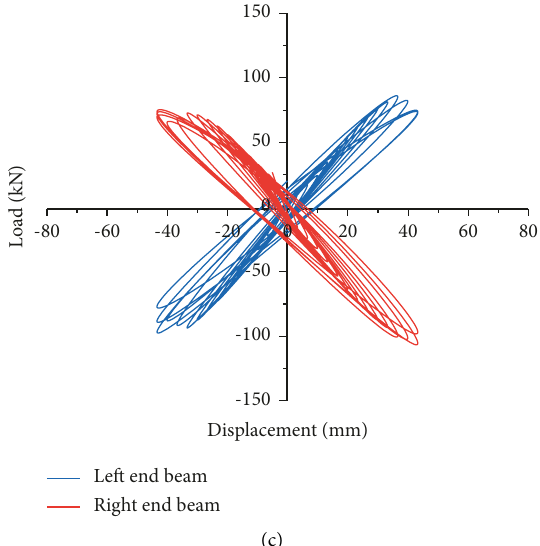
Figure 11: Load-displacement hysteretic curves of the beam end. (a) CFST-1, (b) CFST-2, and (c) CFST-3.